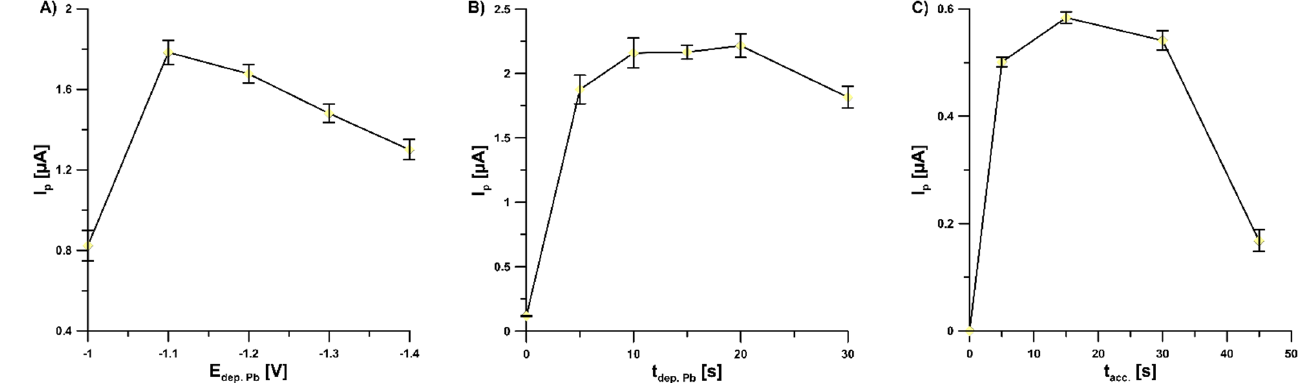
Figure 4. Dependence of V(V) peak current on: ( A ) E dep. Pb , ( B ) t dep. Pb, and ( C ) t acc . Tested solution: 0.3 mol L − 1 buffer solution (CH 3 COONH 4 , CH 3 COOH, and NH 4 Cl) of pH 5.6 ± 0.1, 5.0 × 10 − 4 mol L − 1 Pb(II), 7.0 × 10 − 4 mol L − 1 cupferron, and 1.0 × 10 − 9 mol L − 1 V(V) ( A , B ) or 5.0 × 10 − 10 mol L − 1 V(V) ( C ). The parameters: 100 mV ( Δ E A ), 20 mV s − 1 ( ν ), and 2 ms (t m ). The average values of Ip are presented with the standard deviation of n = 3.